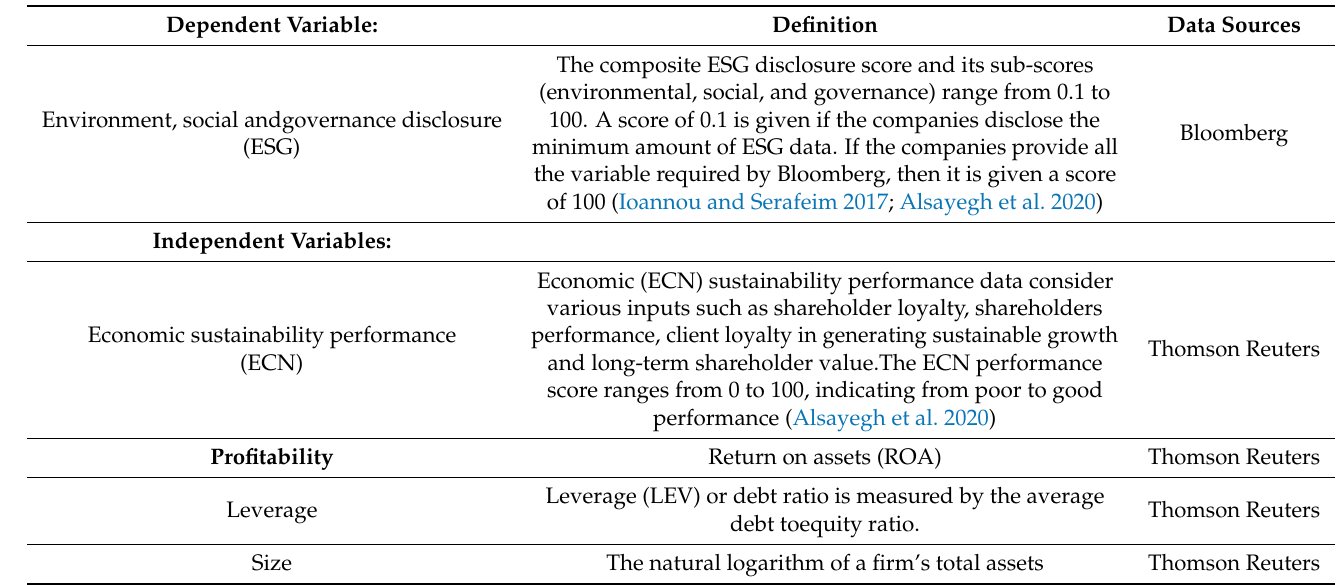
Table 2. Definitions of variables and corresponding data